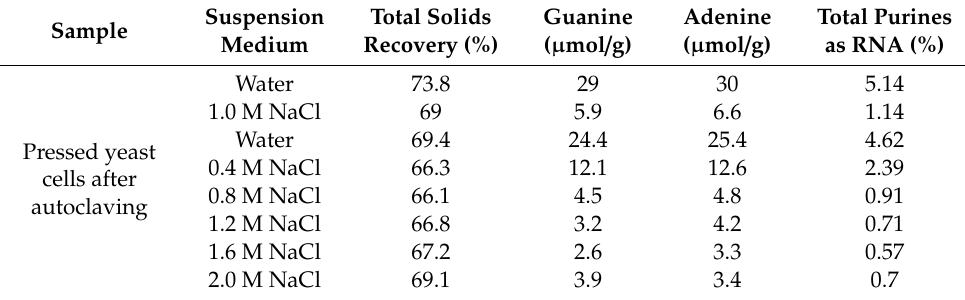
Table 4. Reduction of Purines in Yeast Cells by Applying Heat Treatment in the Presence of NaCl; adapted from Trevelyan et al. (1976)